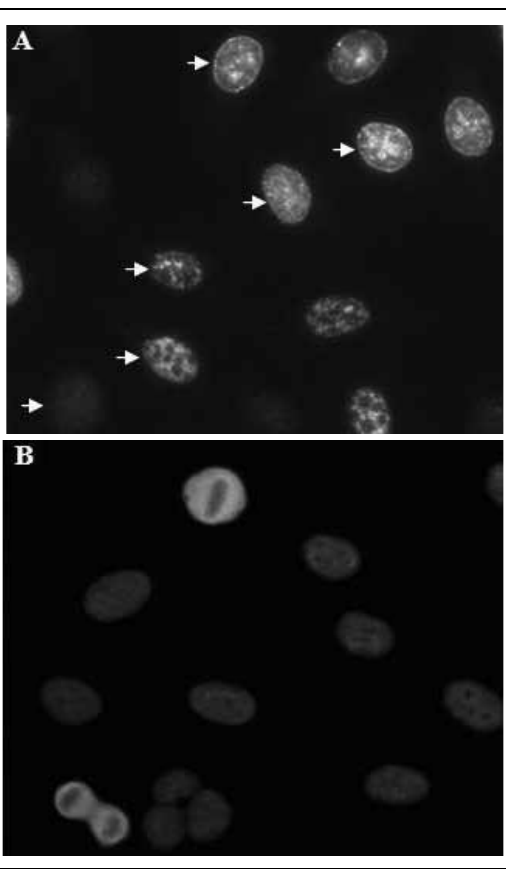
figurE 5 – PCNA pattern Upper panel: expected and observed pattern in slides A and D. The arrows indicate characteristic pleomorphism of the visualized pattern when there is presence of antibodies against cell proliferation antigen. Lower panel: discrepant nuclear fine speckled observed in slides B, C, E, F, G and H. PCNA: proliferating cell nuclear antigen.